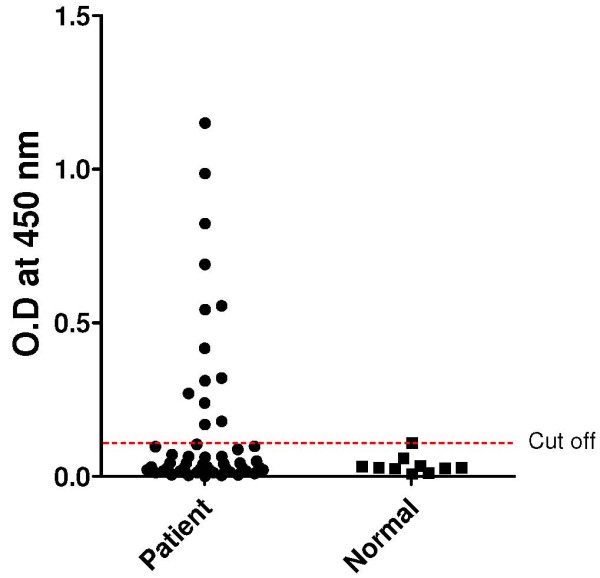
Antigenicity of recombinant circumsporozoite protein. Patient, individual infected with Plasmodium vivax; Normal, healthy volunteers.